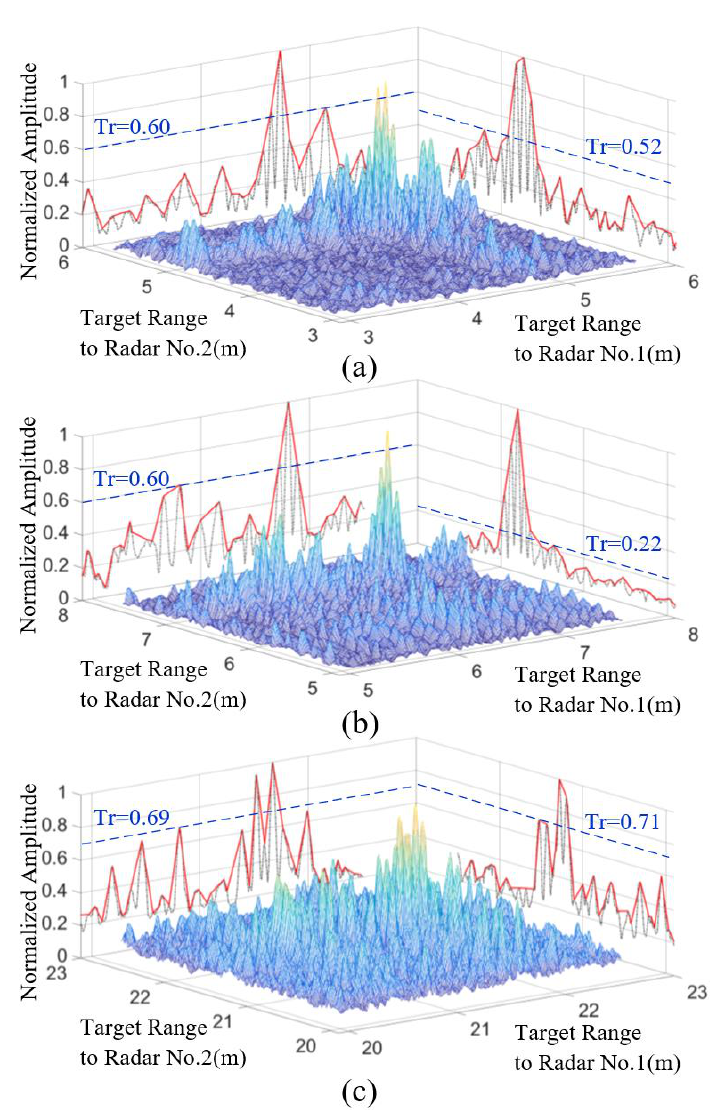
Figure 9. The output 2D slice (range × range) images for the specific respiration frequencies in ( a ) the type-I, ( b ) the type-II and ( c ) the type-III experiments,